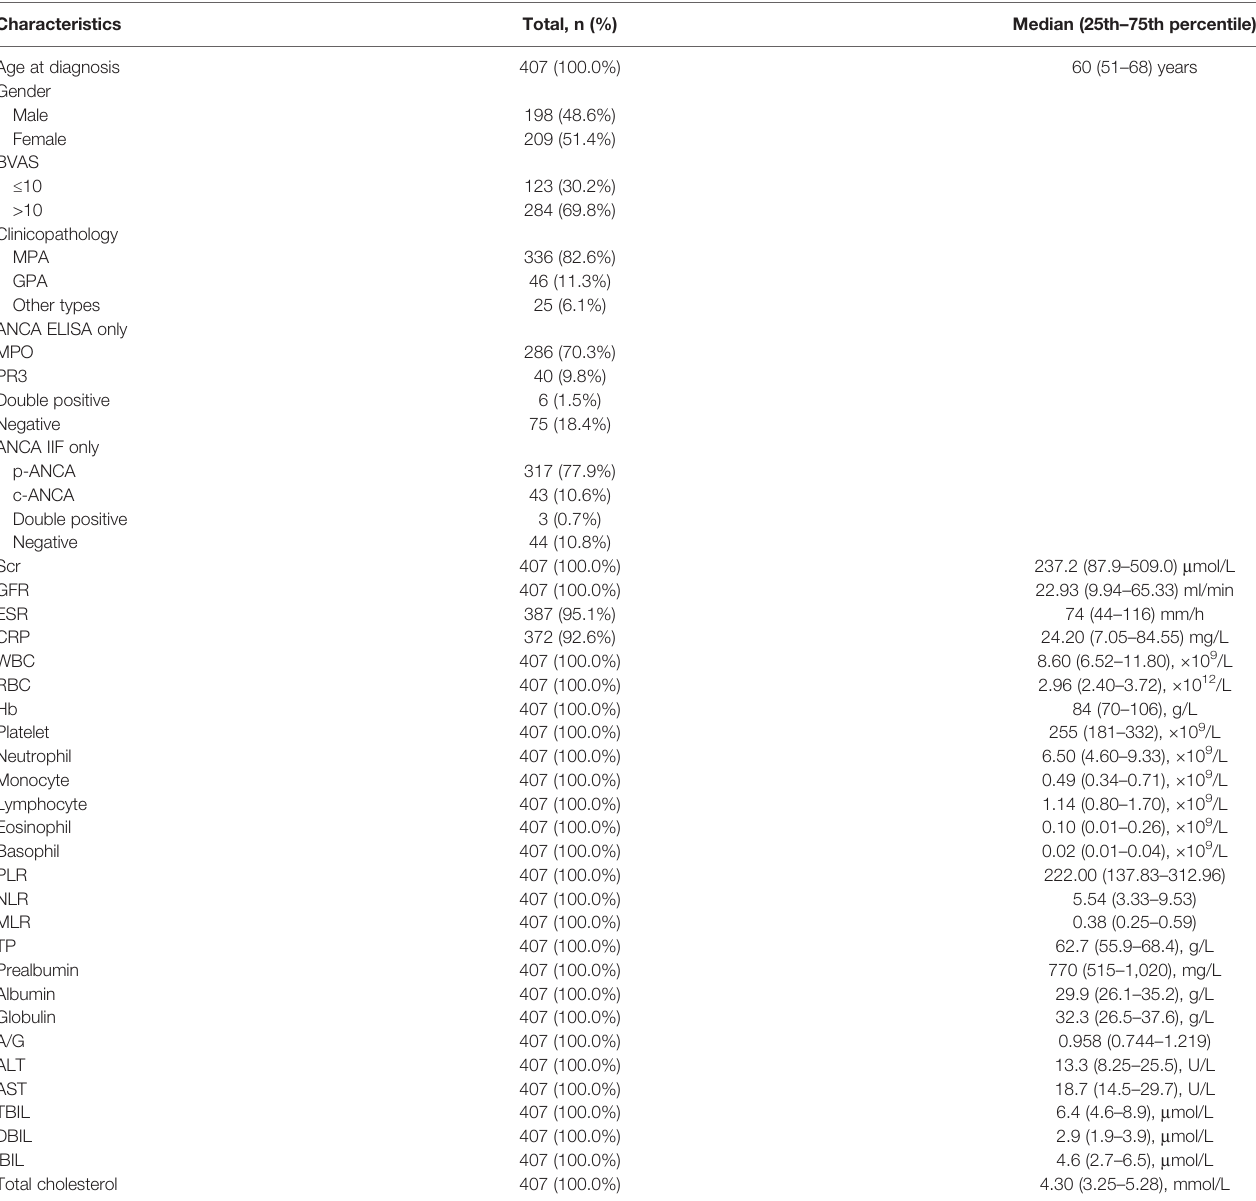
TABLE 1 | The baseline characteristics of 407 patients with ANCA-associated vasculitis.